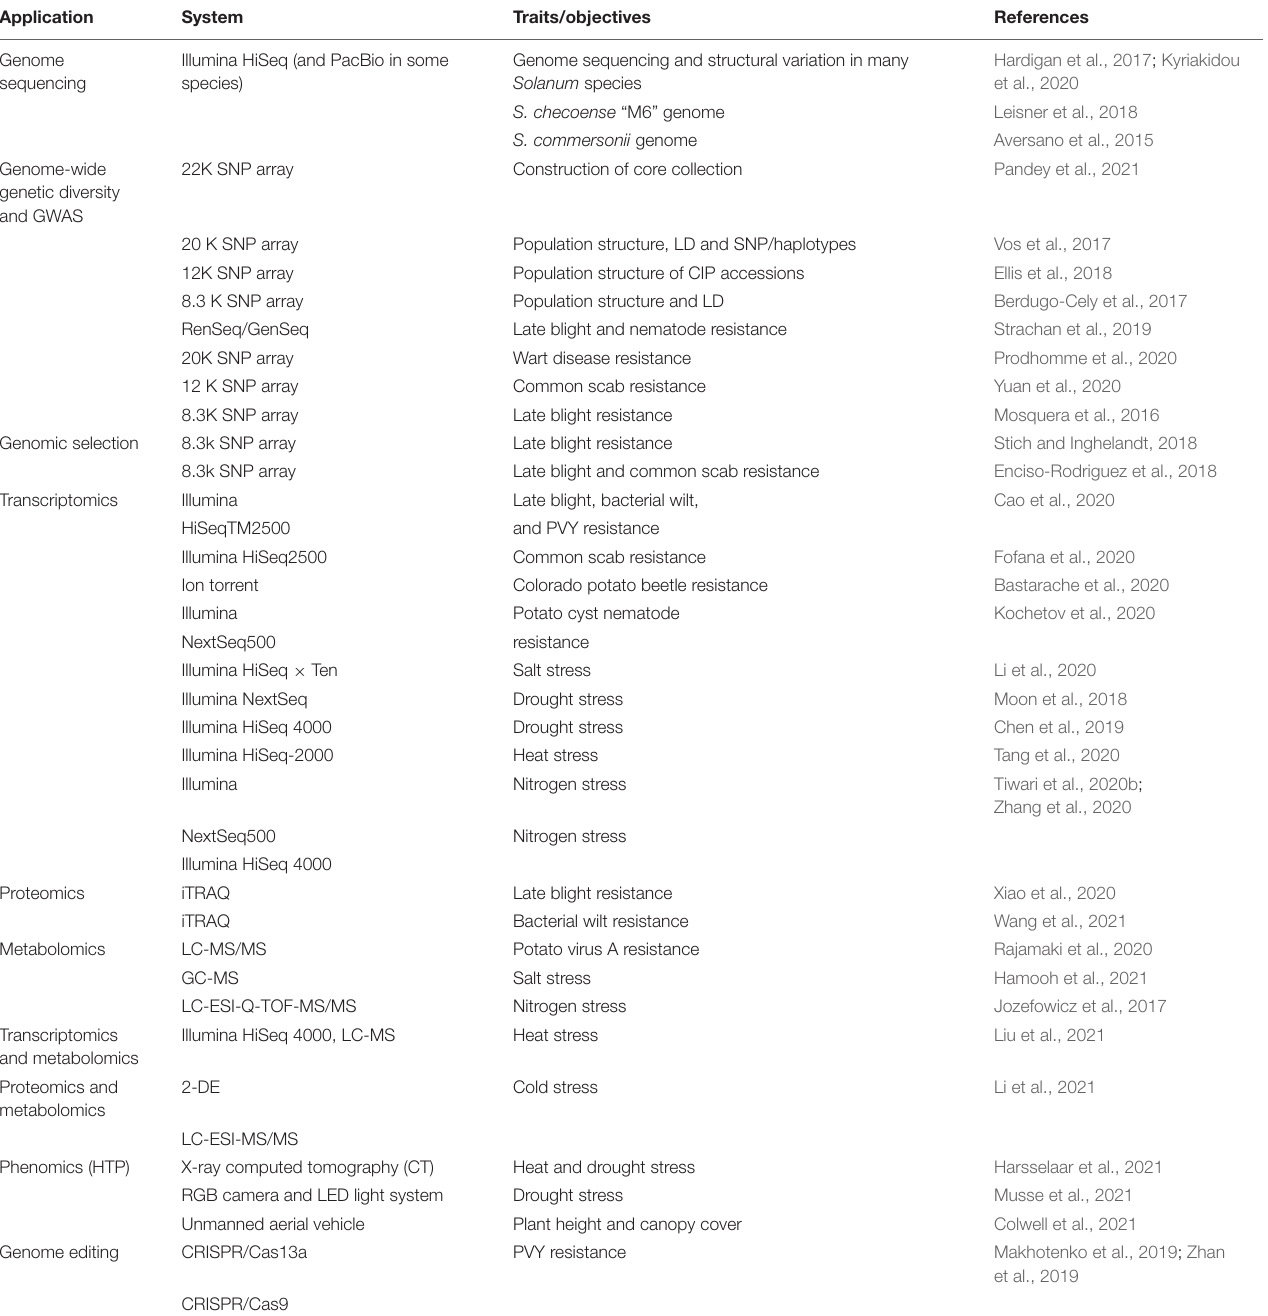
TABLE 1 | A few recent examples of application sequencing and multi-omics technologies in potato for biotic and abiotic stress